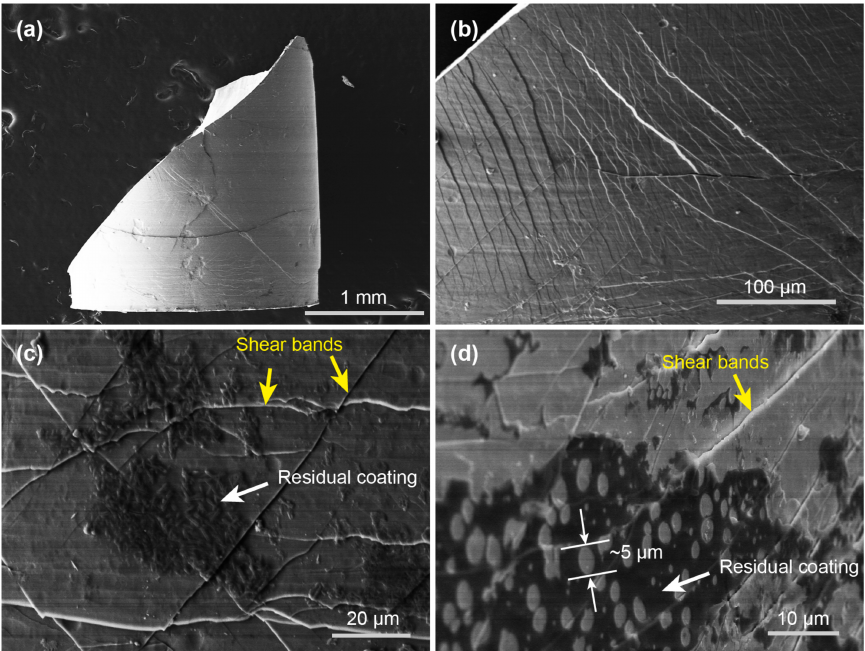
Figure 6. The SEM images showing the side of typical Ni-coated BMG sample after fracture. ( a ) The overall image of the bottom part of the ruptured sample after compression; ( b ) Higher magnification image showing multiple shear bands; ( c ) Residual coating on the surface; and, ( d ) Peeling trace of the coating in the residual coating.